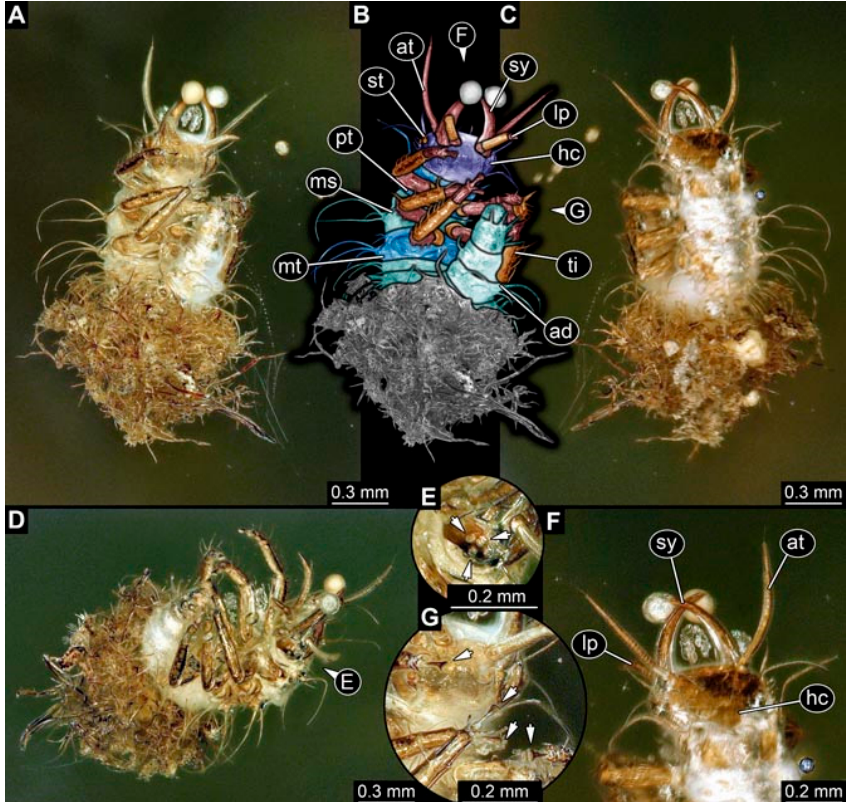
Figure 48. Specimen 4703 (SMF Be 2021); Chrysopidae; Baltic amber. ( A ) Ventral view. ( B ) Ventral view, colour-marked. ( C ) Dorsal view. ( D ) Antero-ventral view. ( E ) Close-up of stemmata (arrows). ( F ) Close-up of head capsule in ventral view. ( G ) Close-up of trunk appendages with empodia (arrows). Abbreviations: ad = abdomen; at = antenna; hc = head capsule; lp = labial palp; ms = mesothorax; mt = metathorax; pt = prothorax; st = stemmata; sy = stylet; ti = tibia.